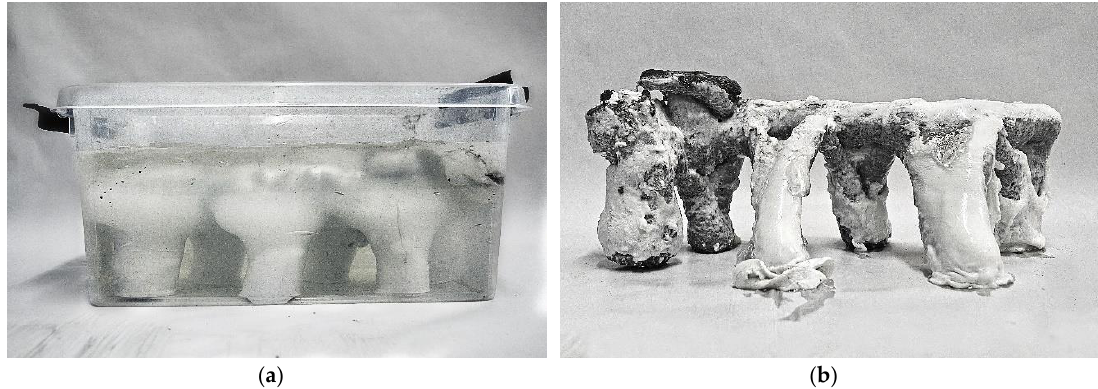
Figure 5. Initial experiment for the purpose of calibration: ( a ) zig zag geometry printed into gel, ( b ) the object after 48 hours of curing inside the gel.